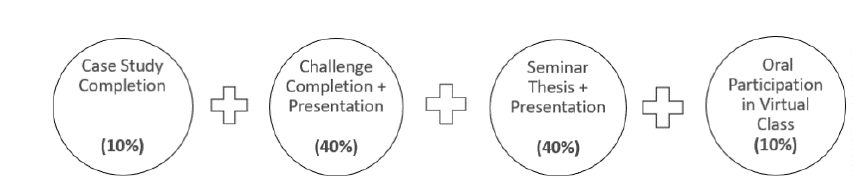
Fig. 5. The four elements of the online module